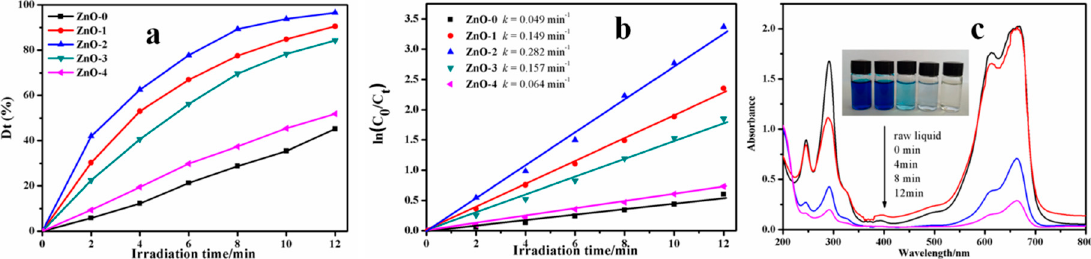
Figure 6. ( a ) D t ~ t of the samples ZnO-0~4; ( b ) The pseudo-first-order reaction rate constant of the samples ZnO-0~4; ( c ) Absorbance spectra for photocatalytic degradation of MB on the sample ZnO-2.